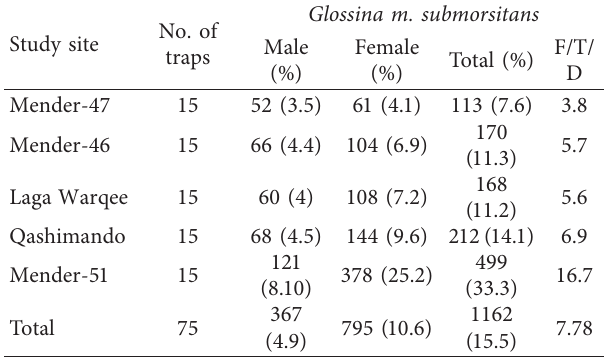
Table 1: Proportion of the F/T/per male and female Glossina species in the study